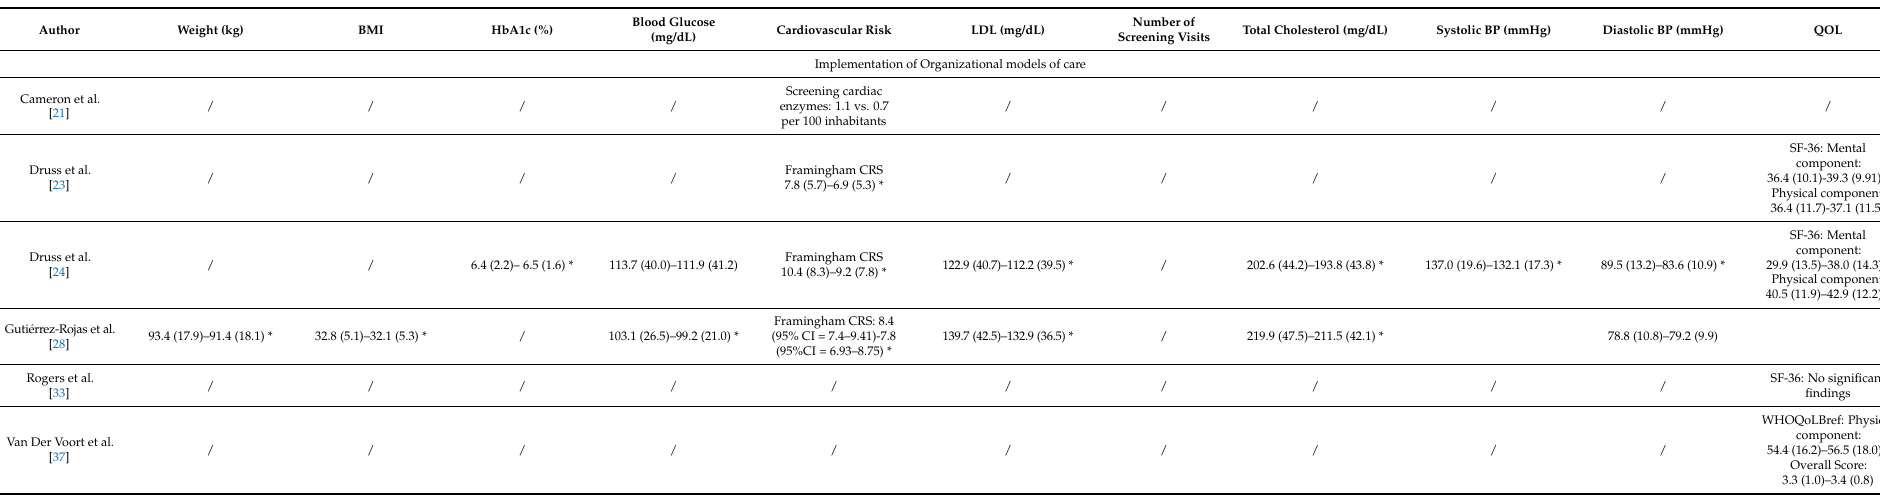
Table 3. Summary of intervention outcomes concerning the implementation of organizational models of